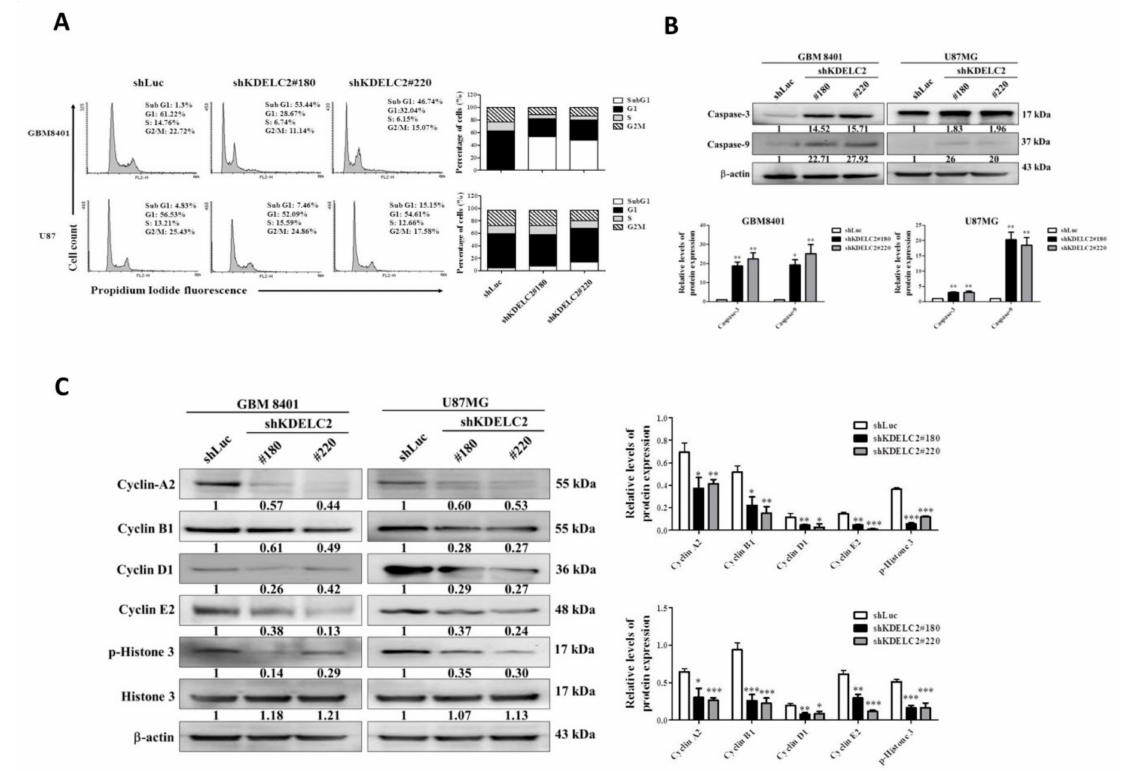
Figure 4. KDELC2 knockdown interrupted cell cycle in glioblastomas (GBMs). ( A ) Flow cytometry assay showed an increase in the sub-G1 phase of GBMs after shKDELC2 transfection. ( B ) Knockdown of KDELC2 increased caspase 3 and caspase 9 expression. ( C ) Inhibition of cell cycle checkpoint expression in shKDELC2-transfected GBMs. Bars, means ± SEM. * p < 0.05; ** p < 0.01; *** p <